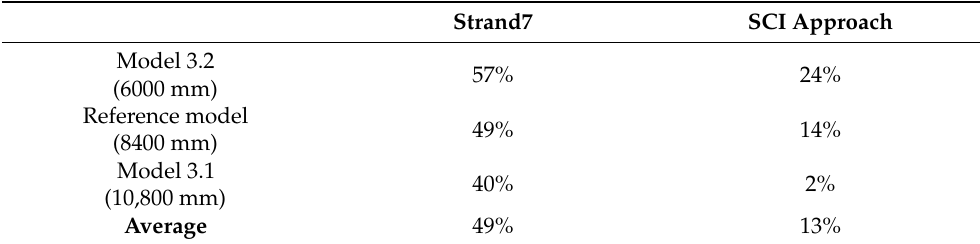
Table 16. Possible error between different approaches (change in secondary beam length).